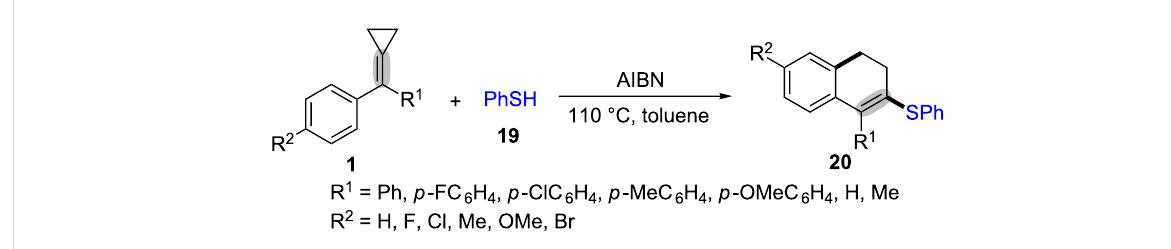
Scheme 6: AIBN-promoted oxidative radical ring-opening and cyclization of MCPs with benzenethiol.